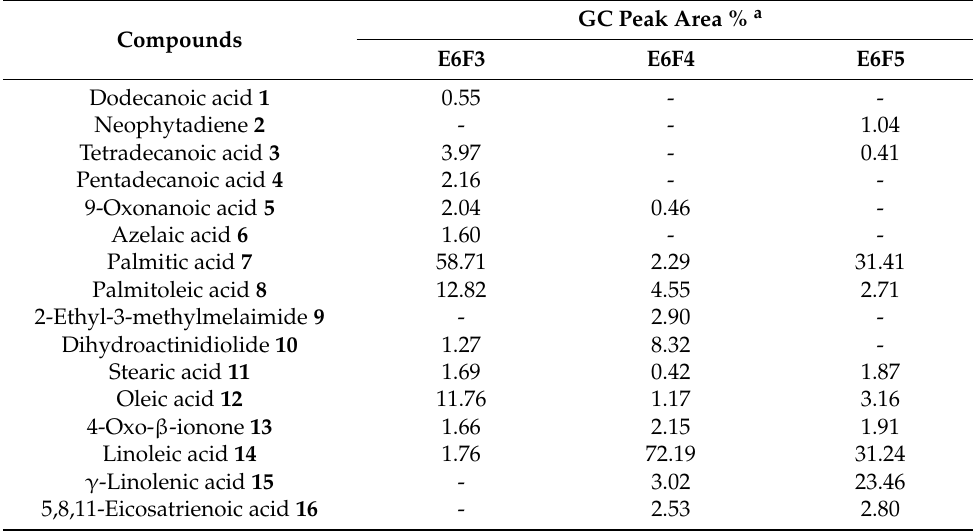
Table 1. Chemical compositions of active subfractions E6F3-E6F5 of S. platensis